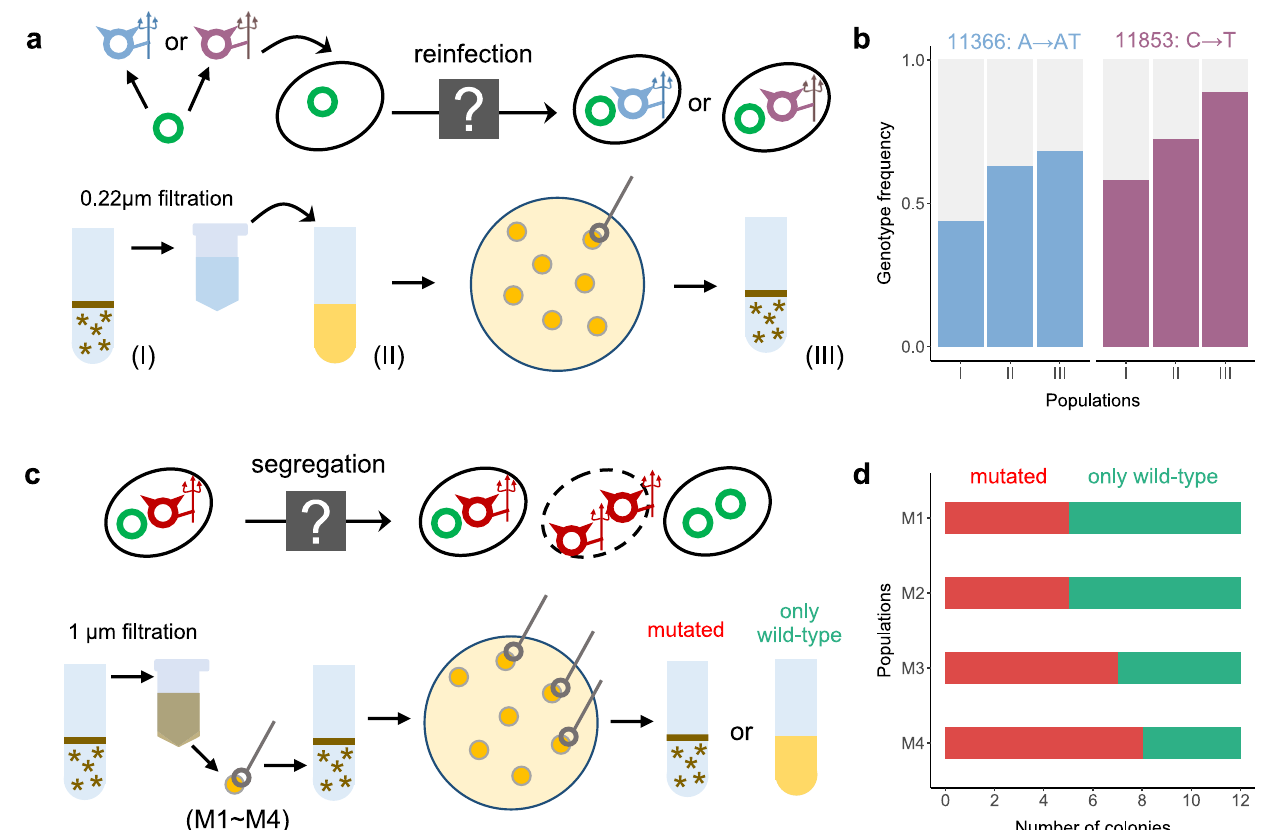
Fig. 2 | Experimental con fi rmation of reinfection and segregational drift. a Schematic illustration of reinfection, for which we hypothesize that mutated phages are able to infect hosts lysogenized by wild-type phages. Wild-type and mutated phage-plasmids were showed as green circles and blue/purple/red color circles. See Methodsforfullexperimentaldetails. b Mutated phages withthe same genotype were observed across (I) the initial source host population carrying the mutated phage, (II) the victim host population re-infected by the mutated phage and (III) the descendant of (II), supporting our hypothesis of reinfection. Experi- ments were performed in biological duplicates with two source host populations